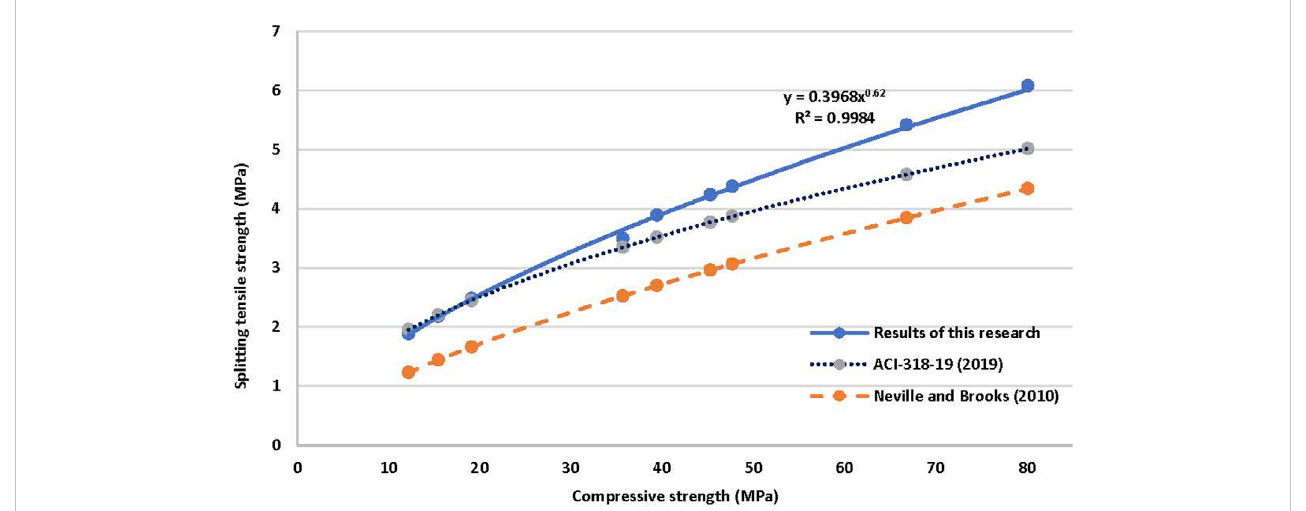
The relationship between the concrete compressive strength and split tensile strength at 90 days.